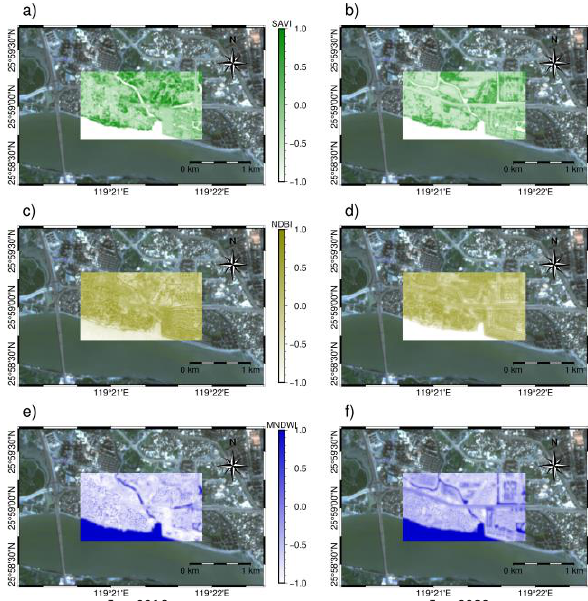
Jan. 2016 Jan. 2022 Figure 7 . The SAVI, NDBI and MNDWI values of area B at January 2016 and January 2022.